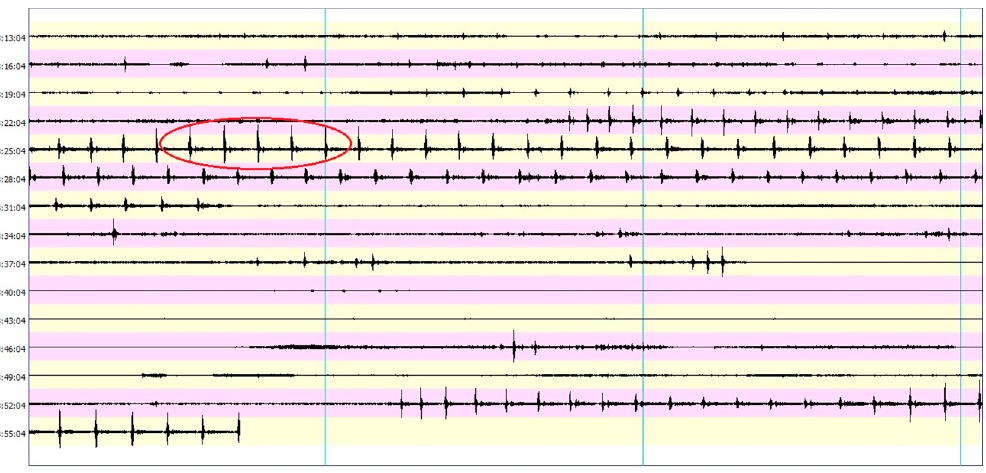
Figure 5. Sample file—commercial seismic station BRS32, five seismic events marked in red.